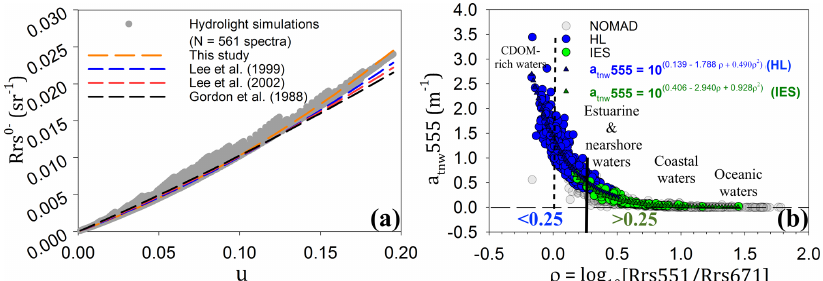
Figure 3. (a) u ( = b b /(a + b b ) ) vs. R 0 − rs for various studies (this study: orange; Lee et al., 1999: blue; Lee et al., 2002: red; Gordon et al., 1988: black) using HL datasets. (b) The relationship between green to red band ratio and a tnw 555 for different datasets (HL: blue, IES: green, NOMAD: grey). Black line shows a threshold to facilitate a smooth transition from in situ to synthetic data in modeling a tnw 555. A dashed line separates data with negative ρ .